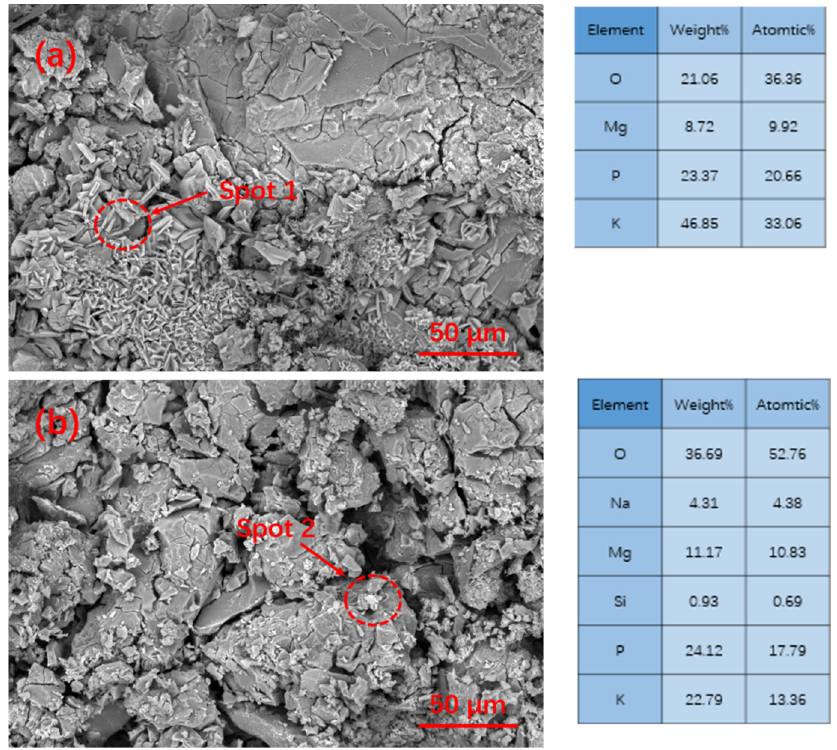
Figure 10. SEM/EDS pictures of MPC with various modi fi ed MgO cured at − 5 °C for 3 h: ( a ) G0; ( b ) G10.